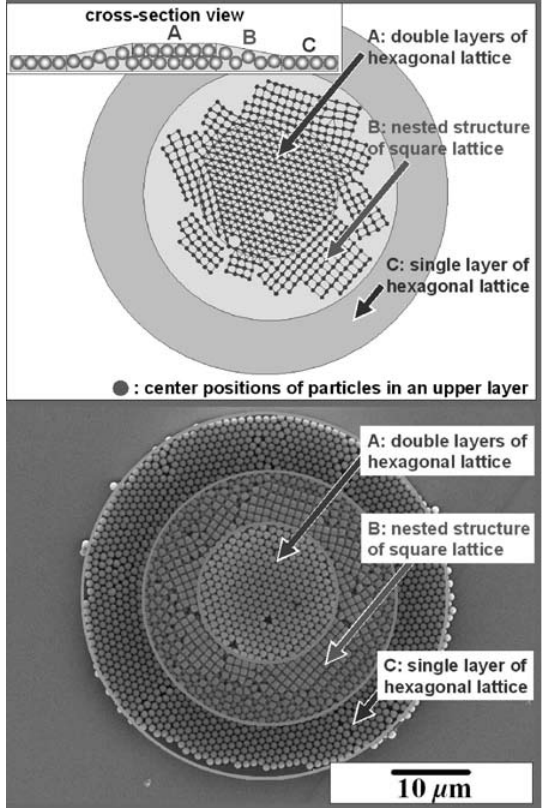
Fig. 3 Particle arrangement view (top) prepared from SEM micrograph (bottom) of patterned colloidal photonic crystals constructed from partially double particle-layers. Center positions of particles in an upper layer show hexagonal or square lattice arrangement regions. The cross-sectional view shows the difference in height caused from the difference in particle arrangement modes. The three colored areas show regions of (A) double layers of hexago- nal lattice, (B) nested structure of square lattice and (C) single layer of hexagonal